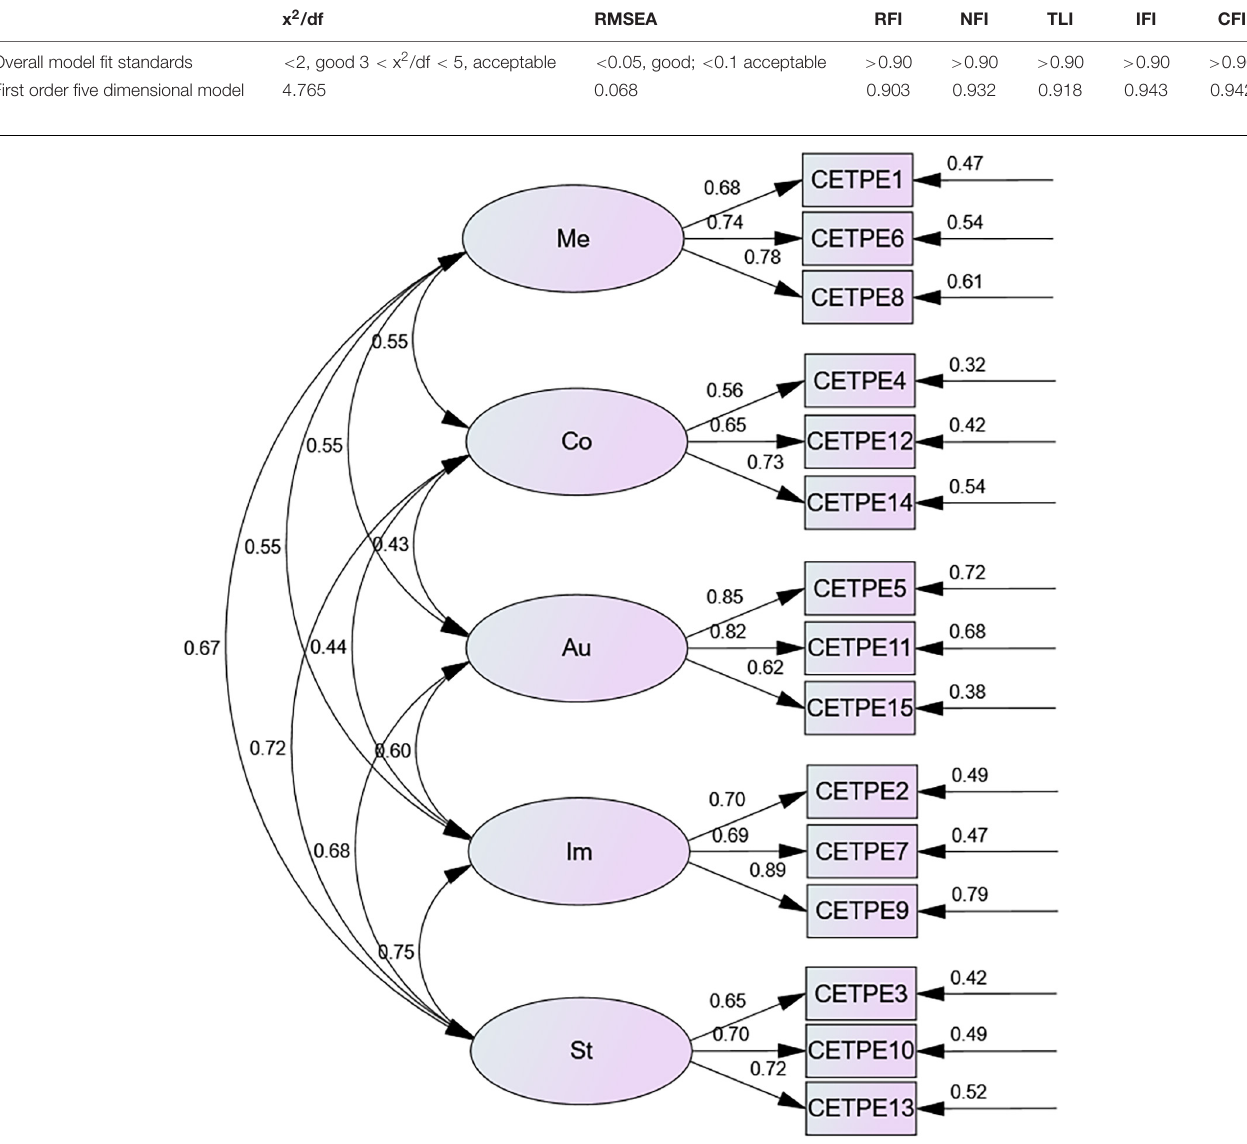
TABLE 14 | Fitting indices of CETPE scale’s SEM. x 2 /df RMSEA RFI NFI